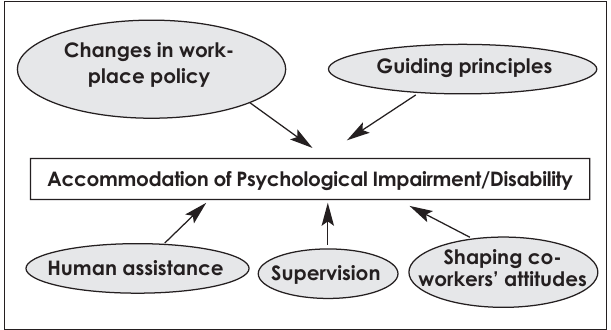
Fig. 2. Holistic model for accommodation of psychologically impaired